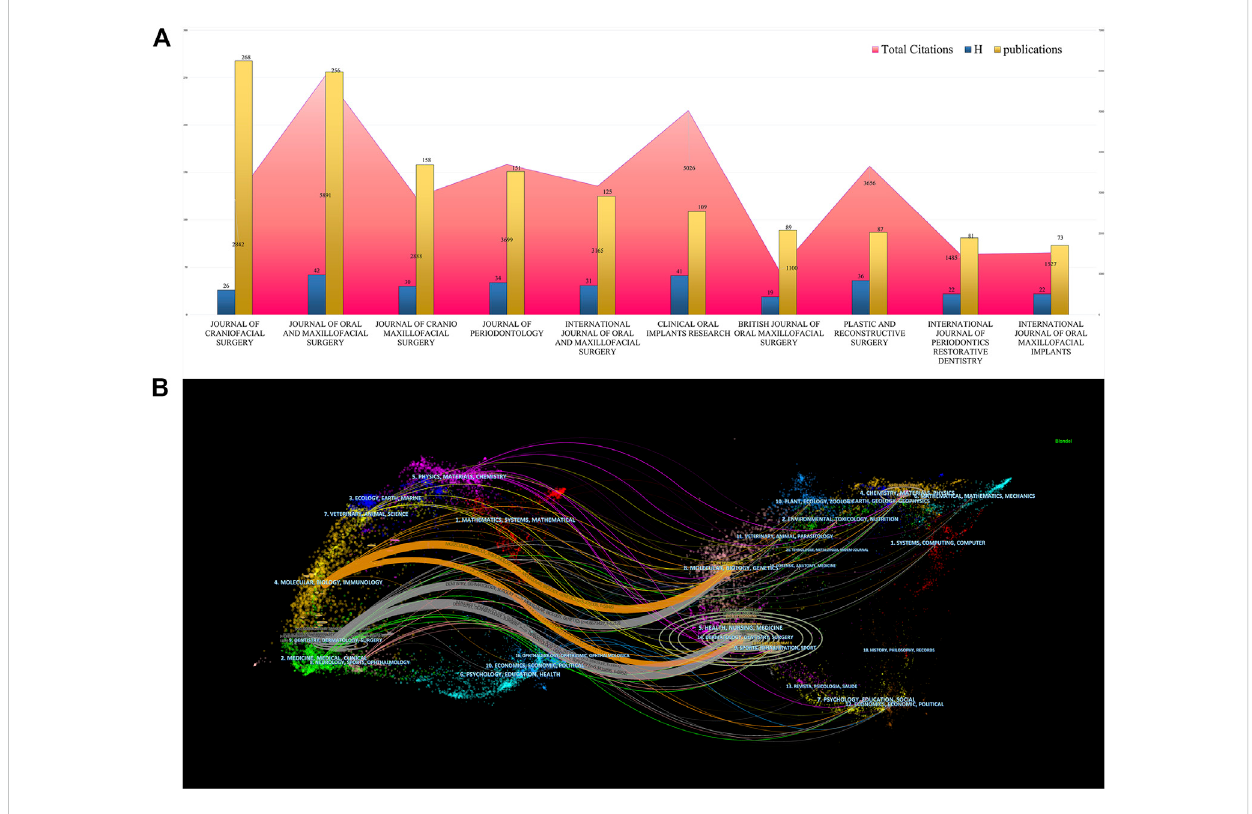
FIGURE 6 Journals analysis of mandibular defect research. (A) The publications, total citations, and H-index of journals of mandibular defect research. (B) The dual-map overlay of journals of mandibular defect research. The left circles were targeted literature while right circles were source literature.